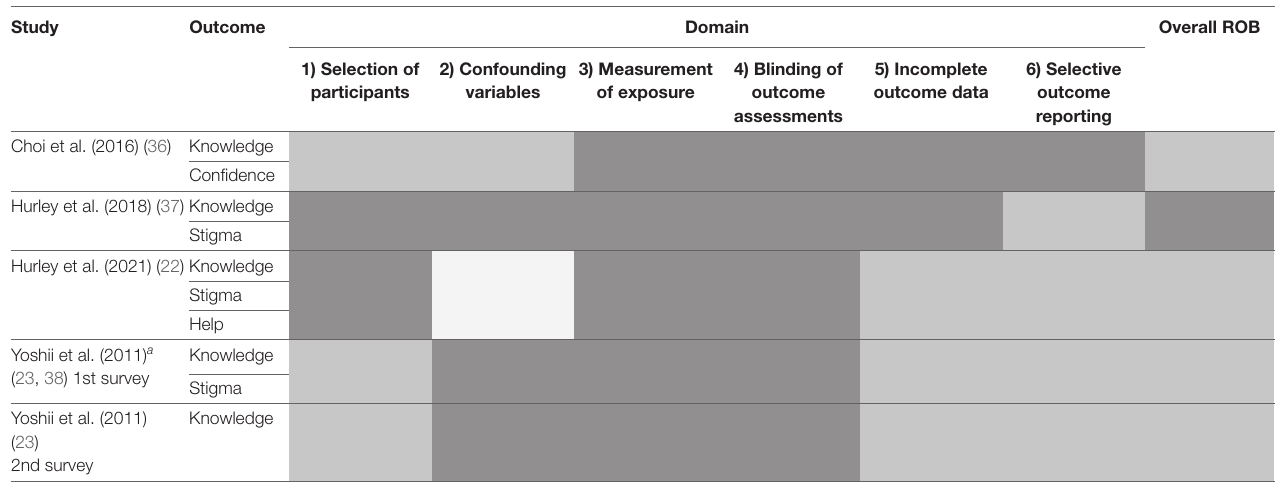
TABLE 3 | ROB in the six domains and overall ROB for 4 outcomes in nonrandomized